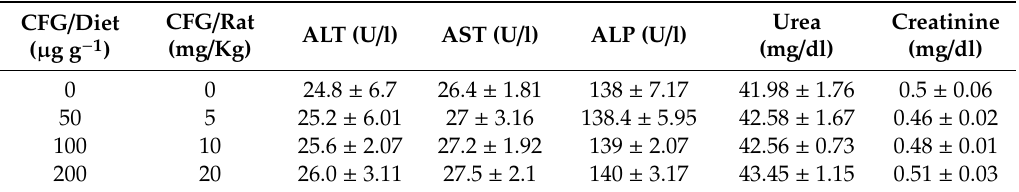
Table 2. The biological e ff ects of the CFG-supplemented beef administered to albino rats during 28 days under standard conditions on the liver and kidney